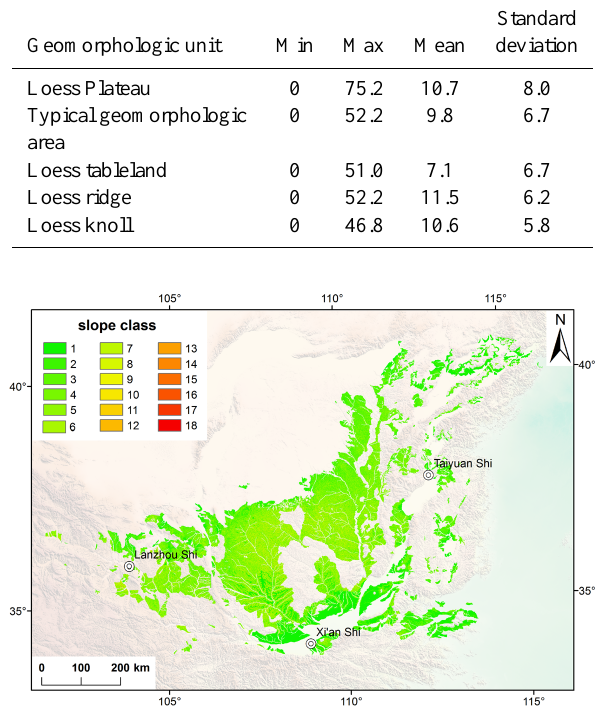
Figure 5. Slope class distribution status in the typical loess geo- morphologic area of the Loess